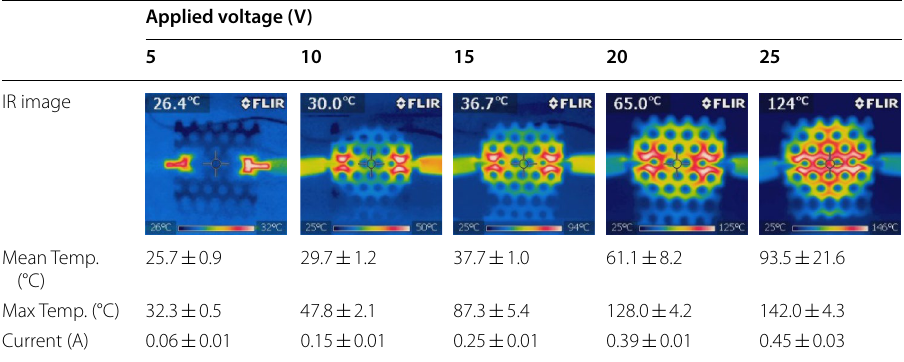
Table 10 IR images of CD graphene/PLA 3D printed honeycomb